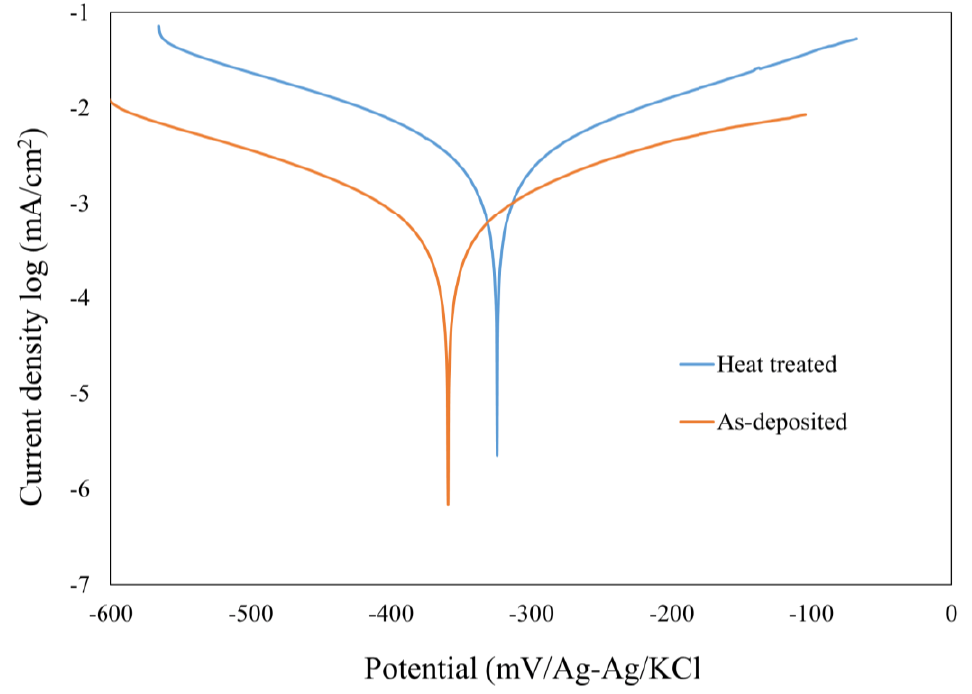
Figure 12. Potentiodynamic polarization curves of the heat-treated and as-deposited electroless nickel-boron deposit electroless.